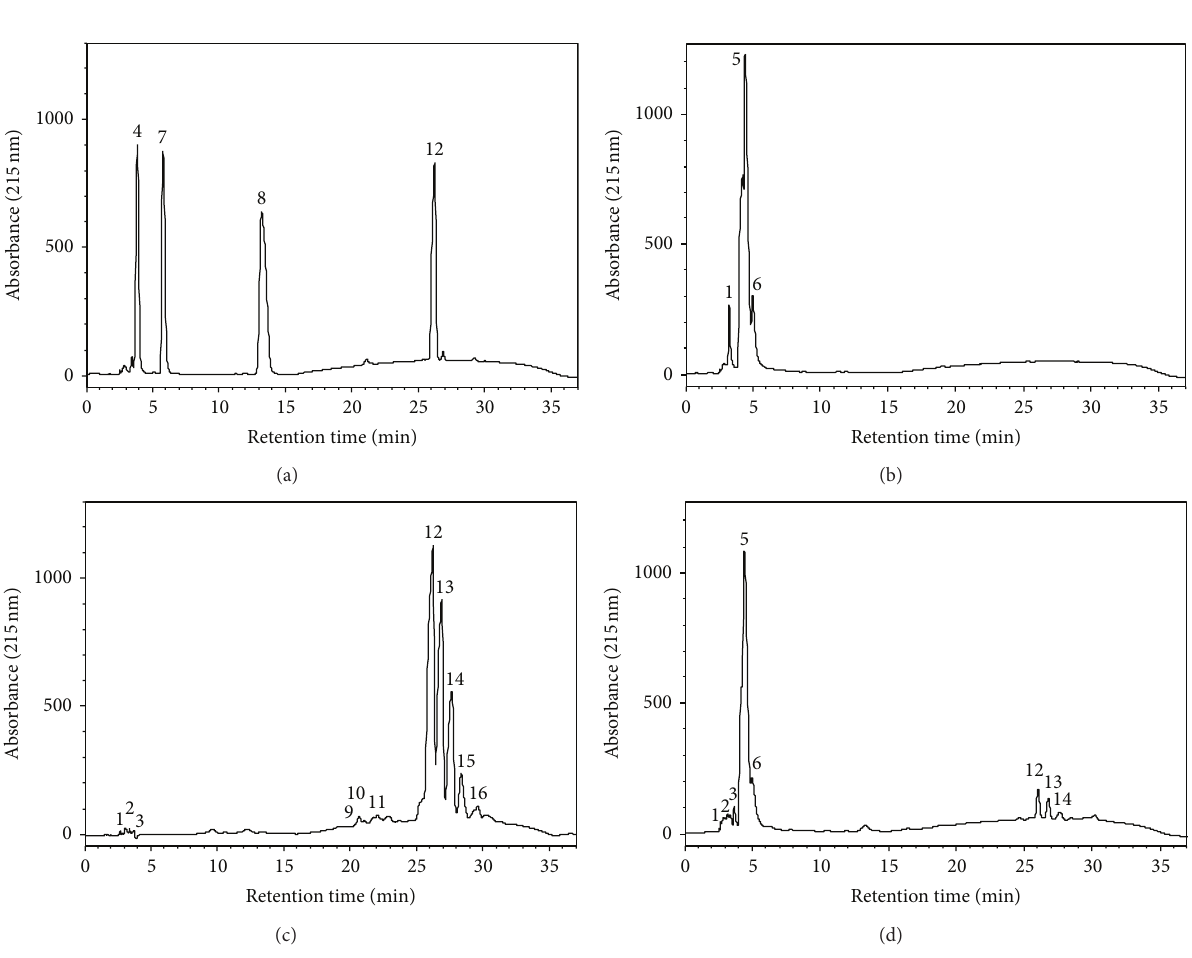
Figure 7: HPLC chromatograms at 215nm of (a) acylglycerols standard (AGs-STD) composed of 25% equal amount of methyl linoleate (CH 3 -LA), monolinolein (MLA), dilinolein (DLA), and trilinolein (TLA), (b) mixture of free fatty acid standards (LA/OA-STD) composed of 67% linoleic acid (LA) and 33% oleic acid (OA), (c) safflower oil (SO), and (d) hydrolyzed safflower oil (HSO). Peak numbers were identified as follows: free fatty acids (FFAs) #1 to 3, 5, and 6, triacylglycerols (TAGs) #9 to 16, MLA #4, CH 3 -LA #7, DLA #8, and TLA